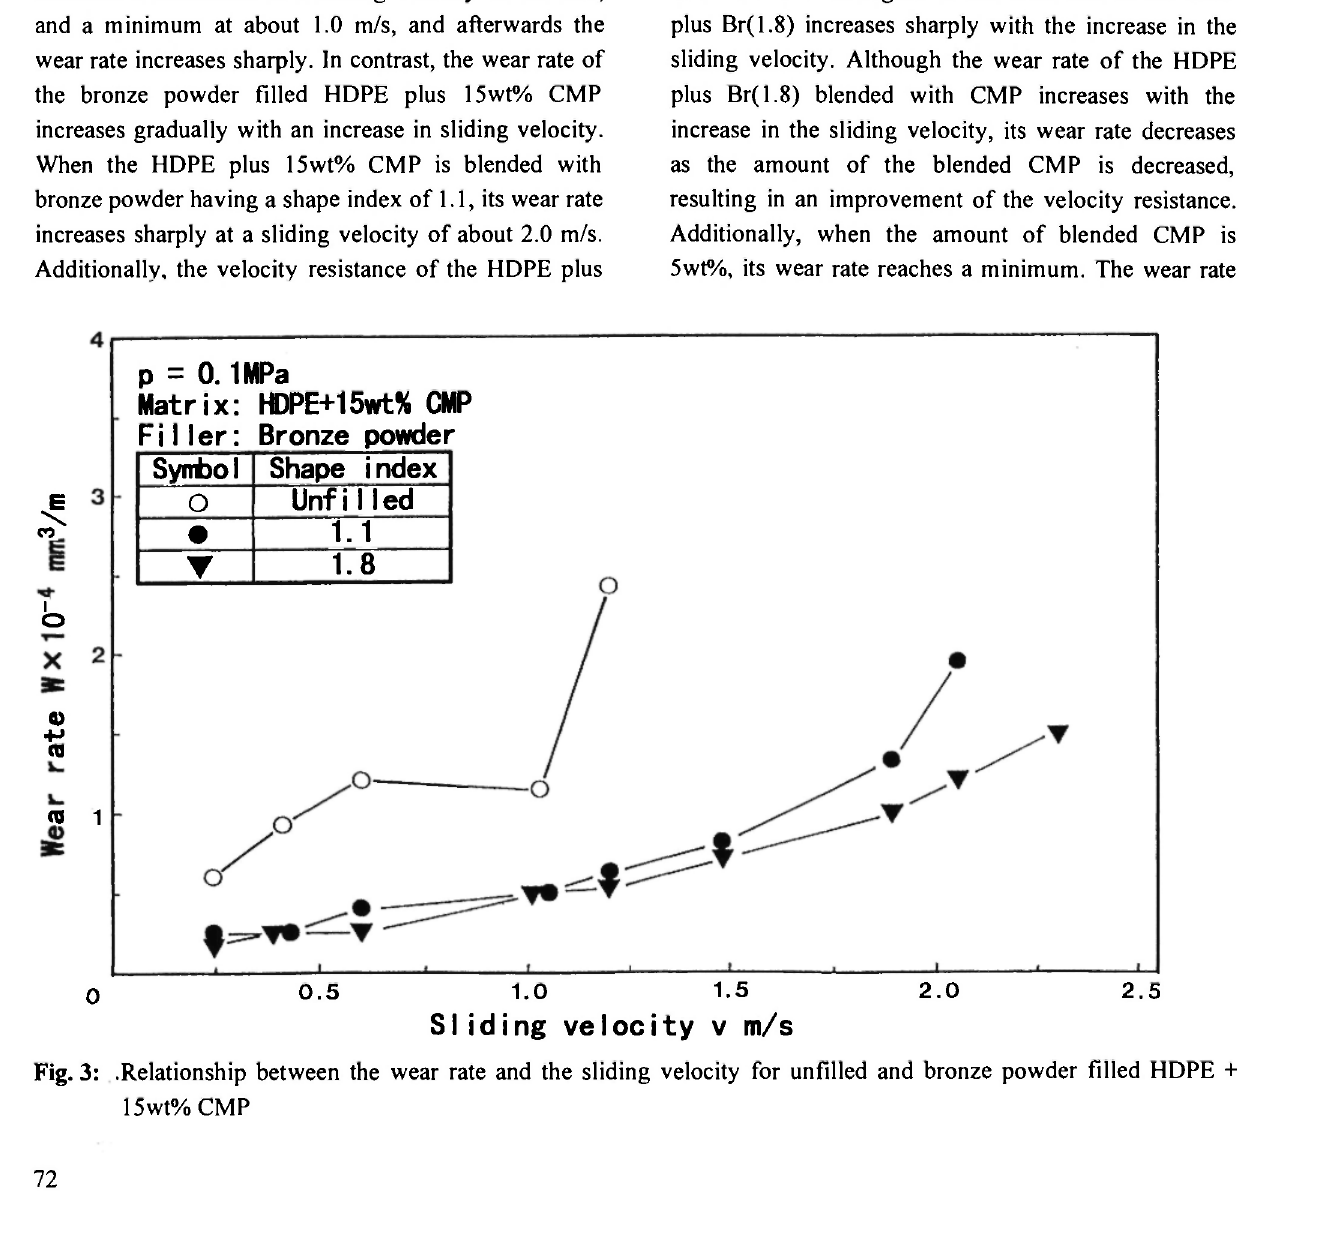
Fig. 3: .Relationship between the wear rate and the sliding velocity for unfilled and bronze powder filled HDPE + 15wt%